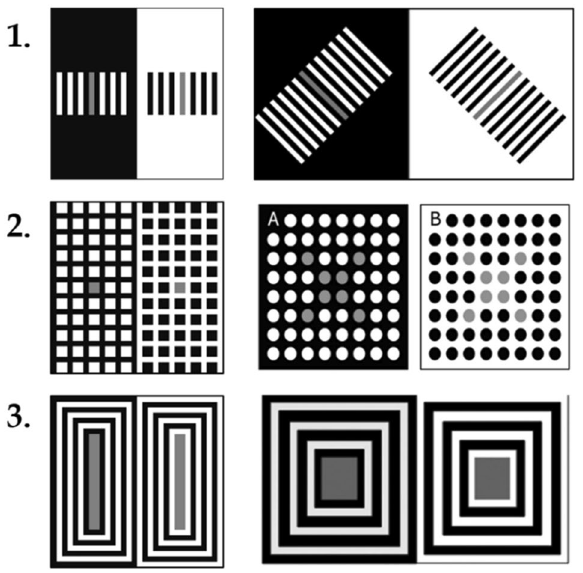
Figure 12. Left column depicts our display in comparison to typical displays used to for testing human observers, presented in the right column used; first row: Reversed contrast, middle row: Dungeon illusion, bottom row: Bullseye